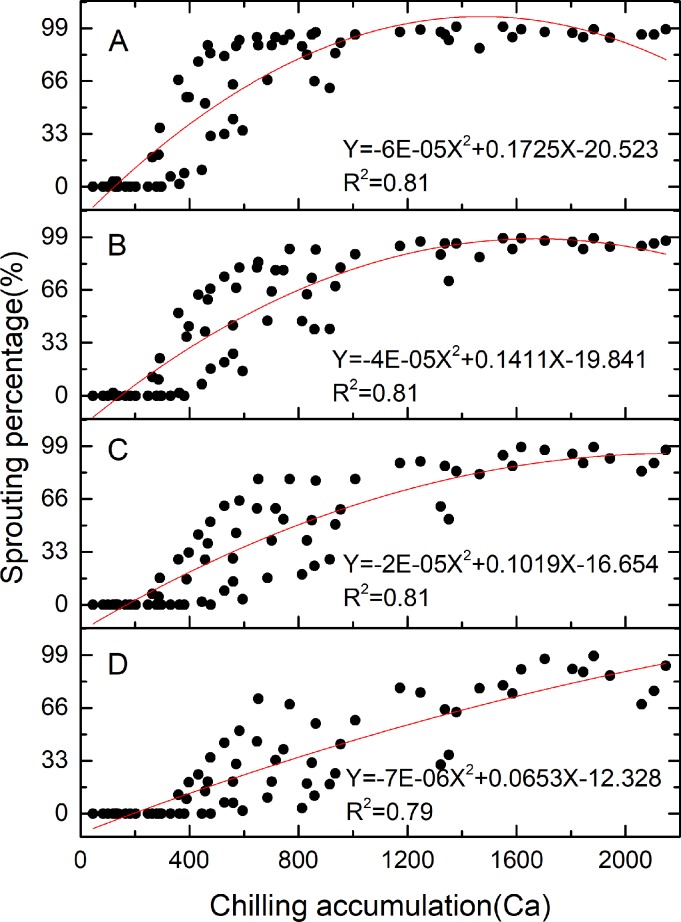
CASkingianum models describing the relationship between chilling accumulation and sprouting percentage at four bud stages.(A) The 37th warming day. (B) The 40th warming day. (C) The 44th warming day. (D) The 50th warming day.